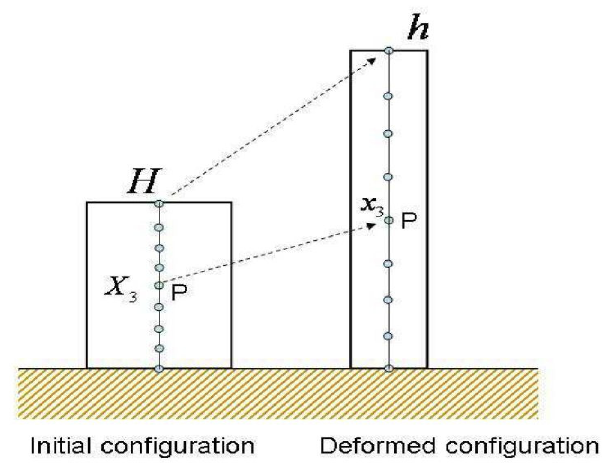
Figure 2. Deformation of a soil column [28].